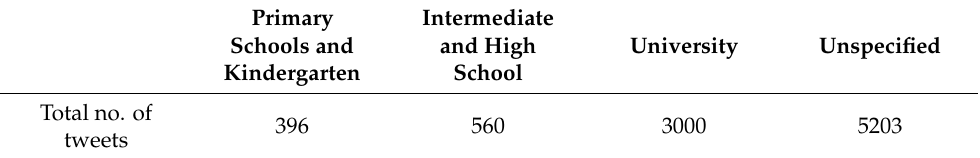
Table 7. Number of tweets in each educational stage for the second dataset (application dataset).